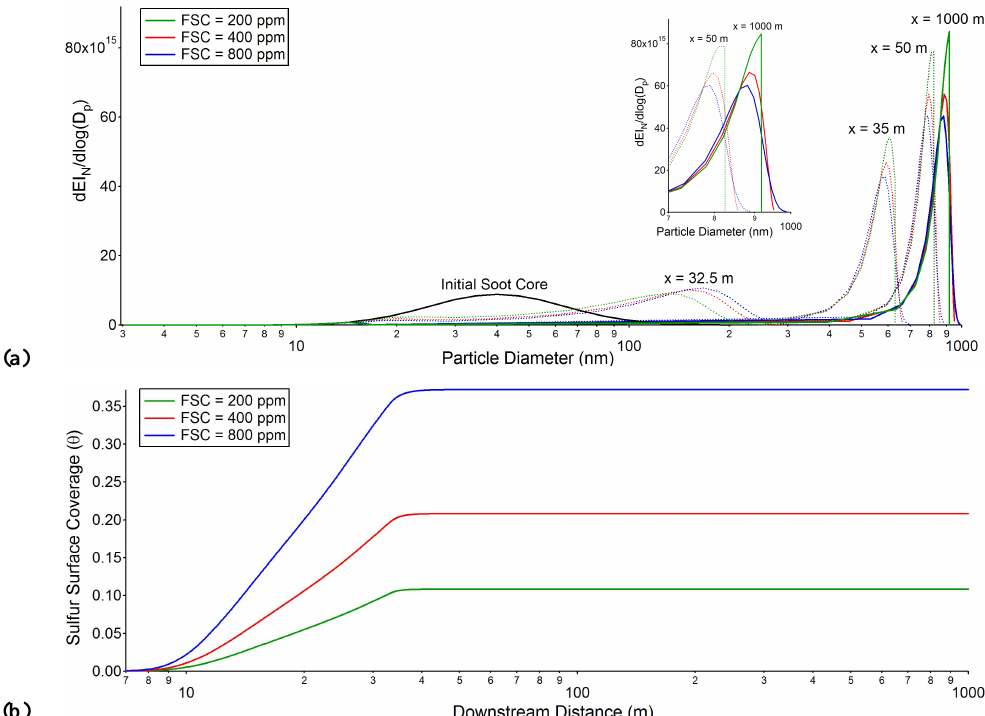
Fig. 6. Effects of fuel sulfur content (FSC) on: (a) ice particle size distributions at downstream distances of 32.5m, 35m, 50m, and 1000m; (b) sulfur activated fraction on soot surface.